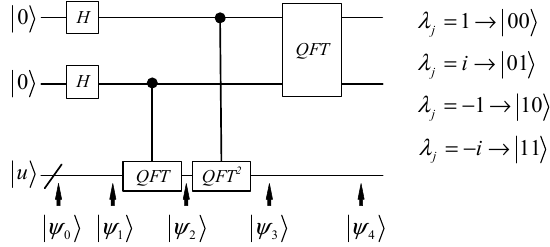
Figure 2. Quantum states corresponding with eigenvalues.